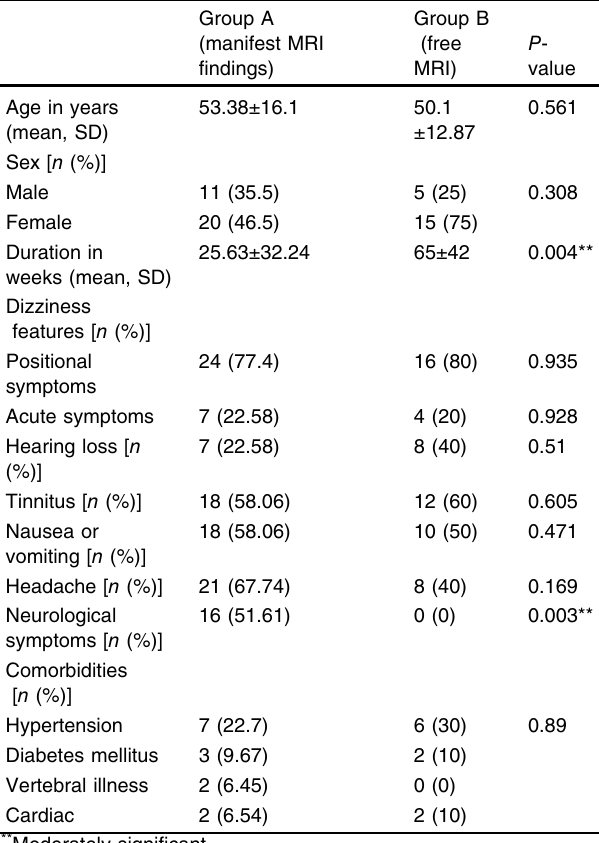
Table 1 Demographic characteristics and clinical manifestations by number and percentage of group A versus